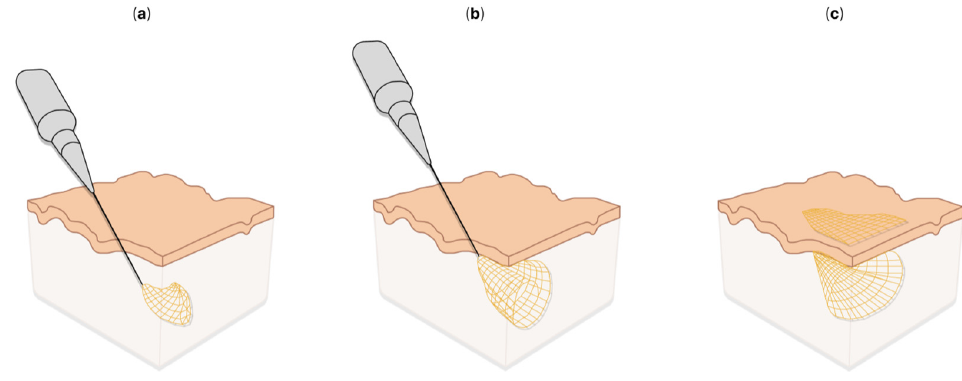
Figure 5. Syringe injection electronics: ( a – c )—schematics of injectable electronics [245]. Tian-Ming Fu et al. [247] also described a mesh microelectrode, but with the number of recording channels increased from 32 to 128. This microelectrode successfully recorded local field potentials and the activity of single neurons from several brain regions in awake mice for 4 months. As the authors noted, this development represents important progress towards the realization of ideal implantable microelectrodes.